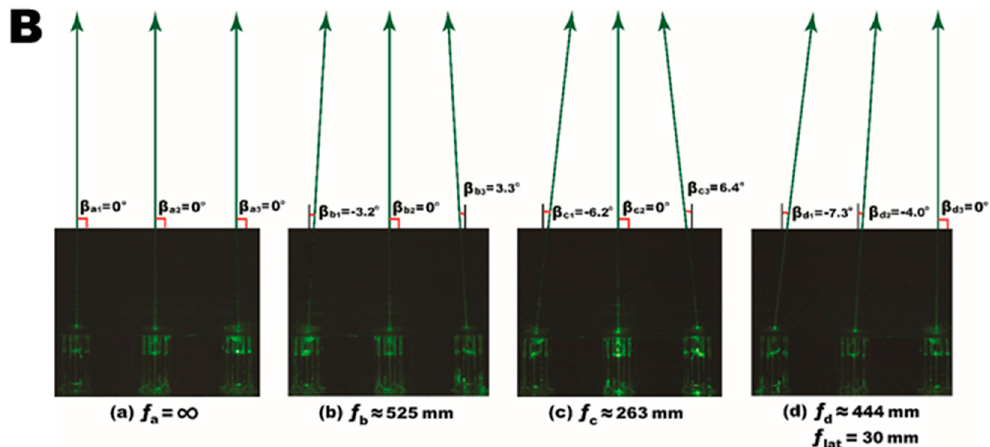
Figure 11. Experimental demonstrations of beam steering with the dip-coatable 3D liquid prisms. ( A ) The top images show the beam deflection using a single prism; ( a ) At ϕ = − 25°, the beam steering was achieved as large as β = − 8.82°; ( b ) At ϕ = 0°, a laser beam passes perpendicularly through the interface; ( c ) Similarly, we can achieve beam steering of β = 8.40° at φ = 24° (reprinted from the Reference [20] with the permission). ( B ) The bottom images present arrayed liquid prims that enable 3D focal tuning by controlling arrayed prisms; ( a ) When all steering angles are zero, β a1 = β a2 = β a3 = 0°, the Fresnel lens does not perform as a concentrating element (i.e., f a = ∞ ); ( b ) When the outer prisms are modulated such that the steering is β b1 = − 3.2°, β b3 = 3.3° and β b2 remains at 0°, the beams converge and the lens is then said to have a focal length at ƒ b ≈ 525 mm; ( c ) Further manipulation at higher angles of β c1 = − 6.2°, β c2 = 0°, and β c3 = 6.4° allows the focal point to reduce from ƒ b ≈ 525 mm to ƒ c ≈ 263 mm; ( d ) By controlling the arrayed prisms ( β d1 = − 7.3°, β d2 = − 4.0°, and β d3 = 0°) non-symmetrically, spatial focal tuning has been achieved in both longitudinal and lateral directions at ƒ d ≈ 444 mm and ƒ lat = 30 mm (reprinted from [21] with the permission).